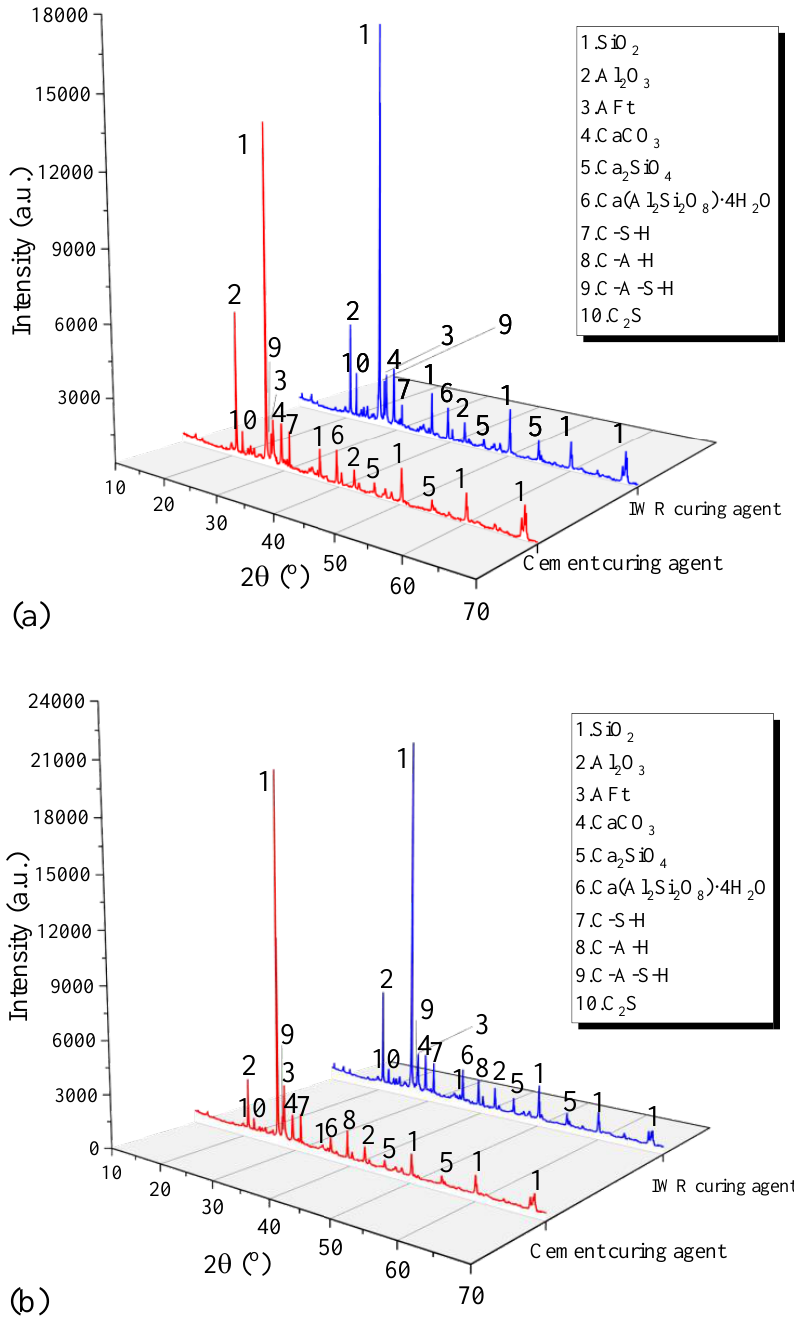
Figure 12. XRD diffraction pattern of improved silt ( a ) at curing age of 7 days, ( b ) at curing age of 28 days.